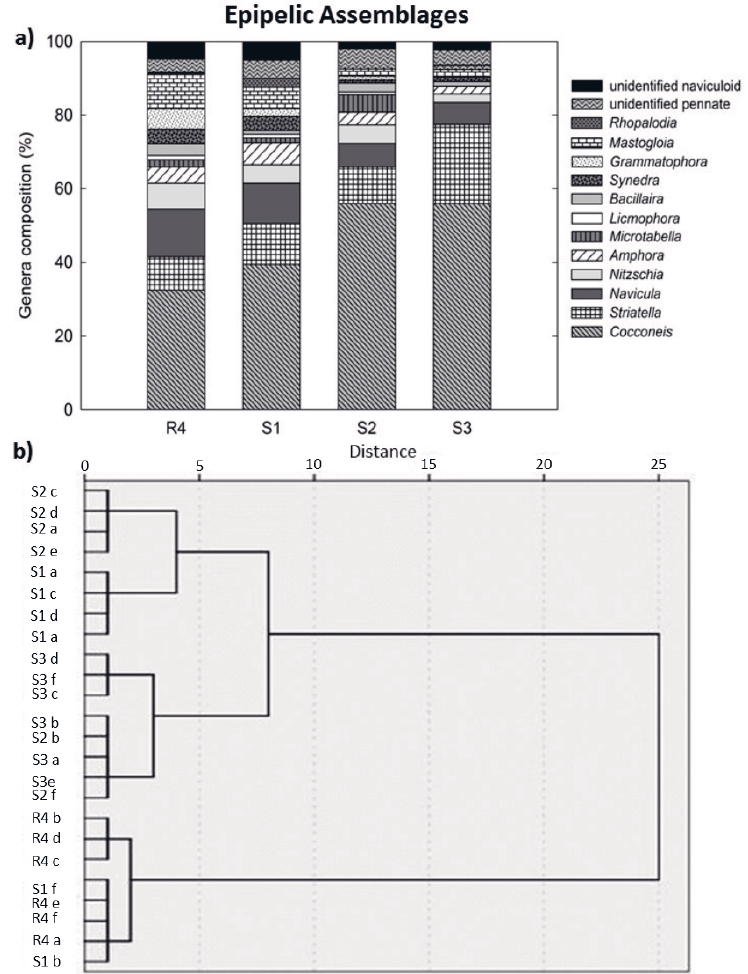
Figure 6. Epipelic diatom assemblages along a natural CO 2 gradient. ( a ) Relative composition of epipelic assemblages at different p CO 2 levels. Bar charts include all genera present over 1% and all unidentified diatoms grouped as unidentified pennate or naviculoid ( n = 6 per station,); ( b ) Hierarchical cluster analyses of the similarity of epipelic diatom assemblage composition based on Ward’s method with squared Euclidian distance for all the sediment samples collected along a natural CO 2 gradient ( n = 24). Analysis consists of all genera present over 1%, including any of the unidentified